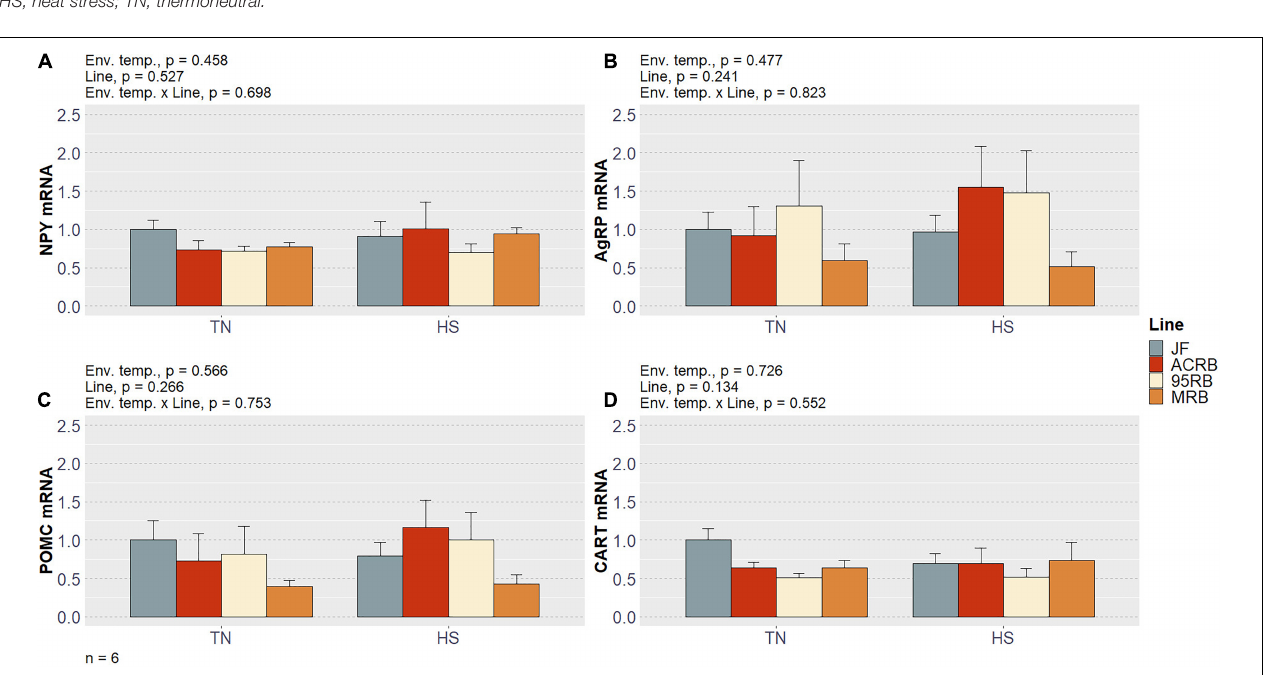
FIGURE 1 | Effect of cyclic heat stress on the hypothalamic expression of NPY (A) , AgRP (B) , POMC (C) , and CART (D) in JF and modern broilers. The mRNA abundances were determined by qPCR using 2 − (cid:49)(cid:49) Ct method. JF-TN group was used as a calibrator. Data are mean ± SEM ( n = 6 birds/group). HS, heat stress; TN,